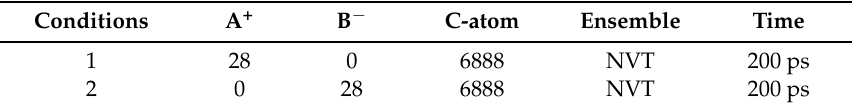
Table 1. The conditions of adsorption of metal and negative